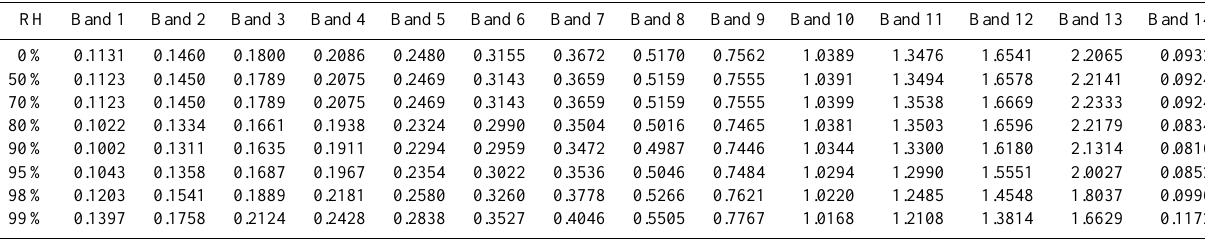
Table A2. AOD spectral scale factor ρ rj for the urban aerosol mixture.